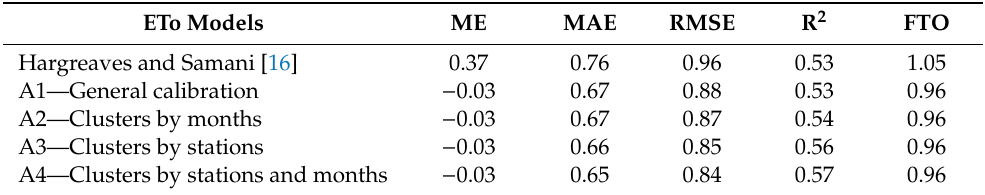
Table 3. Performance criteria of original and improved Hargreaves–Samani models for the period from 2011 to 2016 (test